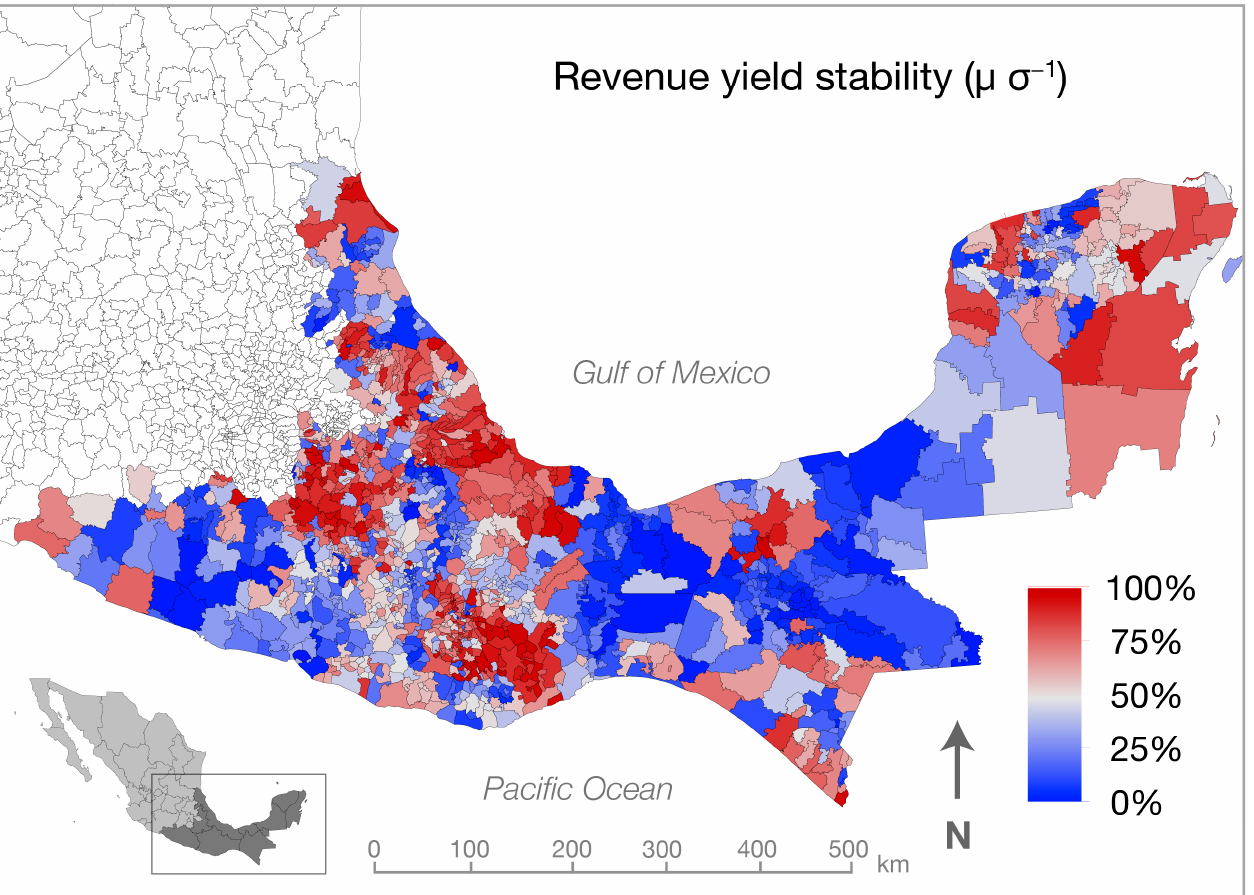
Figure 1. Map of crop revenue stability (relative) in 1340 municipalities of southern Mexico (quantile scale).